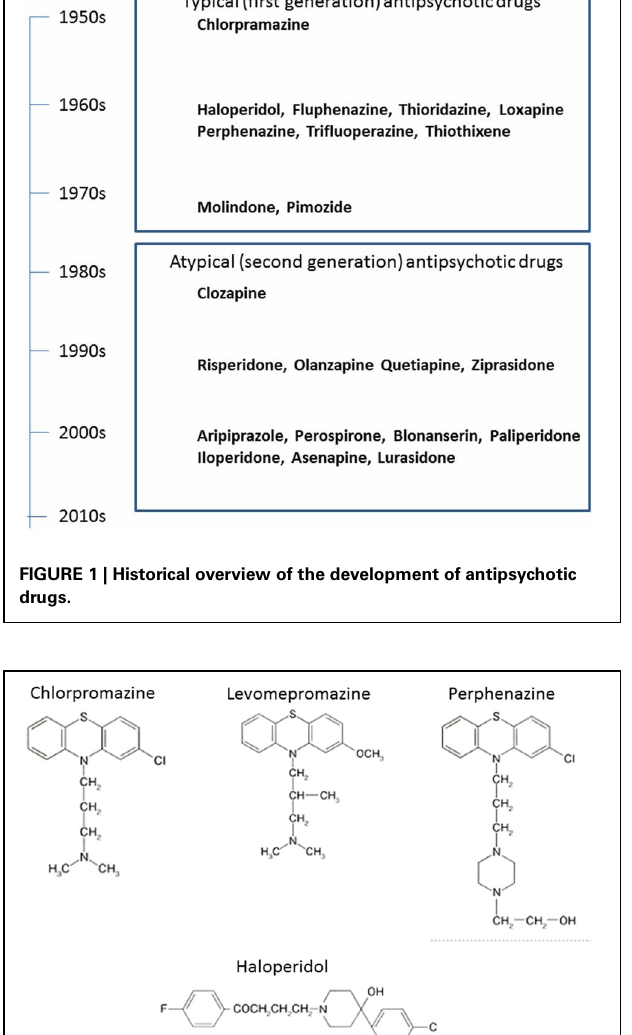
FIGURE 2 | Representative typical (first generation) antipsychotic drugs.